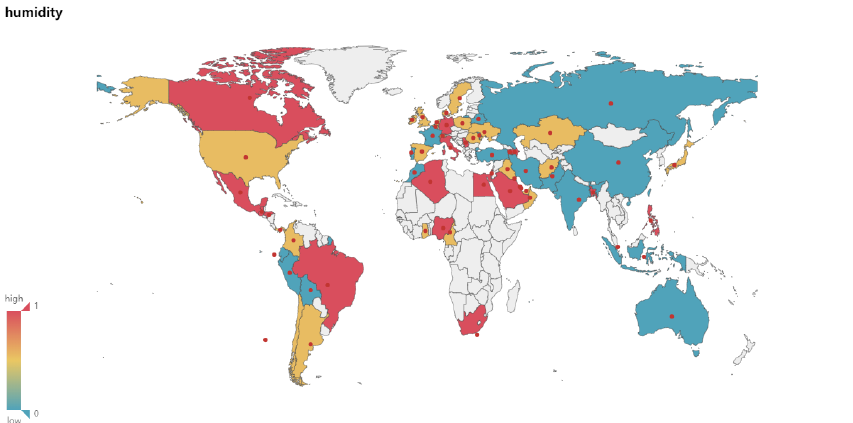
Figure 6. Correlation between New and